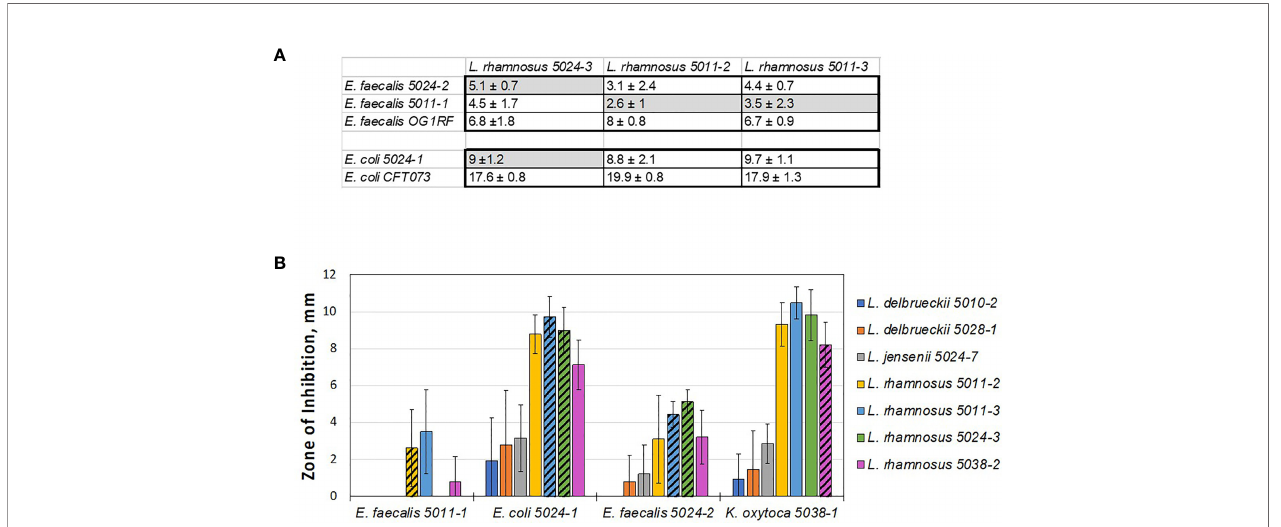
FIGURE 3 | Lactobacilli cohabiting the same bladder with a pathogen still can inhibit that pathogen in vitro . (A) Table showing average zones of inhibition (mm) by cohabiting E. coli and E. faecalis strains. The comparison indicates that cohabiting pathogen strains (shaded in grey) are inhibited by the respective cohabiting commensal urinary lactobacilli but to lesser degree than other pathogen isolates and the model uropathogen strains (no grey shading). (B) Overall screen of patient isolates shows that ‘ better inhibiting ’ lactobacilli strains against one pathogen isolate also show ‘ better inhibiting ’ against another pathogen isolate. In addition, L. rhamnosus strains appear to be better inhibitors, similar to the model screen ( Figure 2